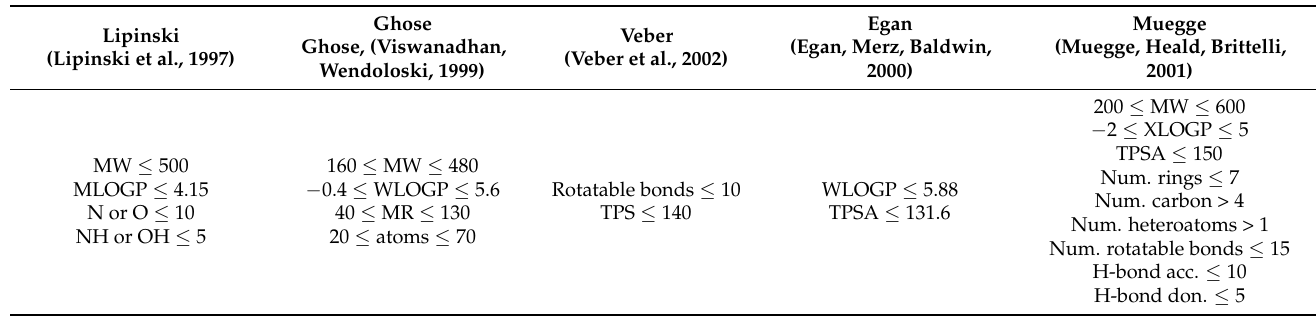
Table 4. Drug-likeness filters used in the